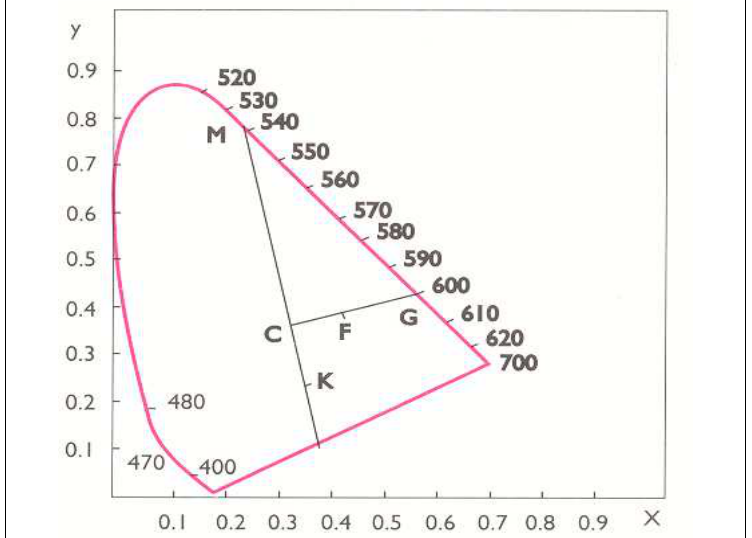
Figure 1 . Determination of dominant wavelength and purity of color by CIE